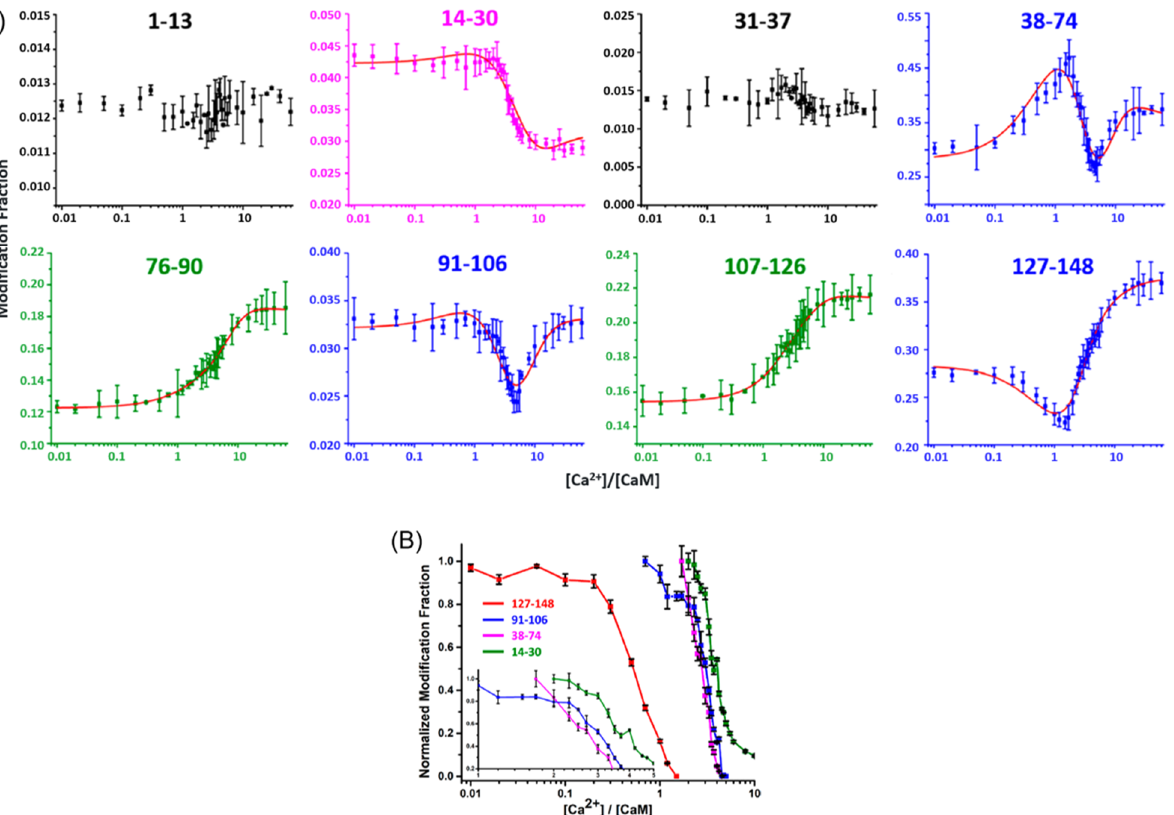
Figure 4. LITPOMS responses of calmodulin upon binding of Ca 2+ . ( A ) for tryptic peptides. ( B ) Normalized modification fraction for tryptic peptide representing each EF-hand. Reproduced with permission from [132]. Copyright 2019 American Chemical Society.